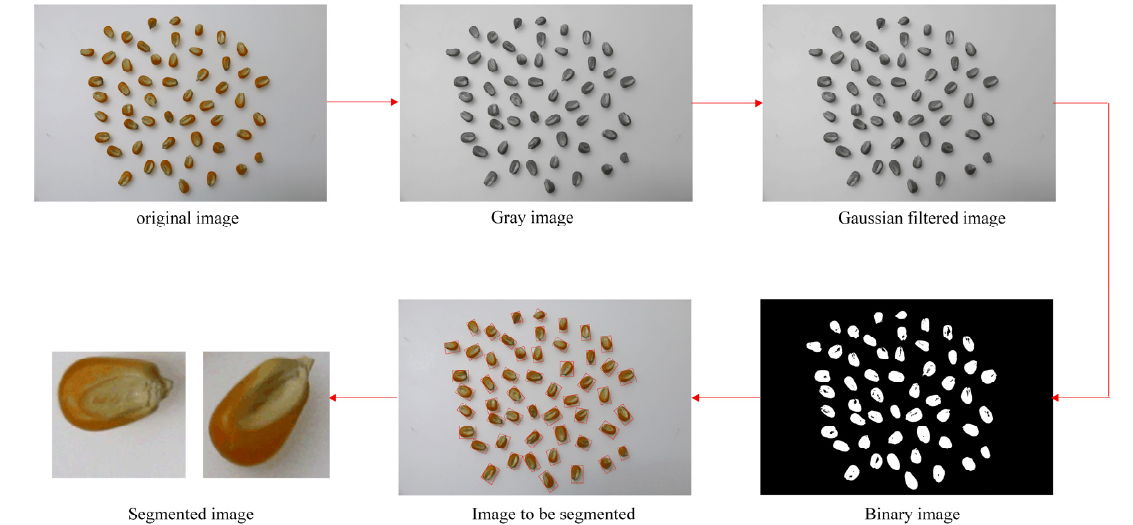
Figure 3. Corn seed image cutting processing.